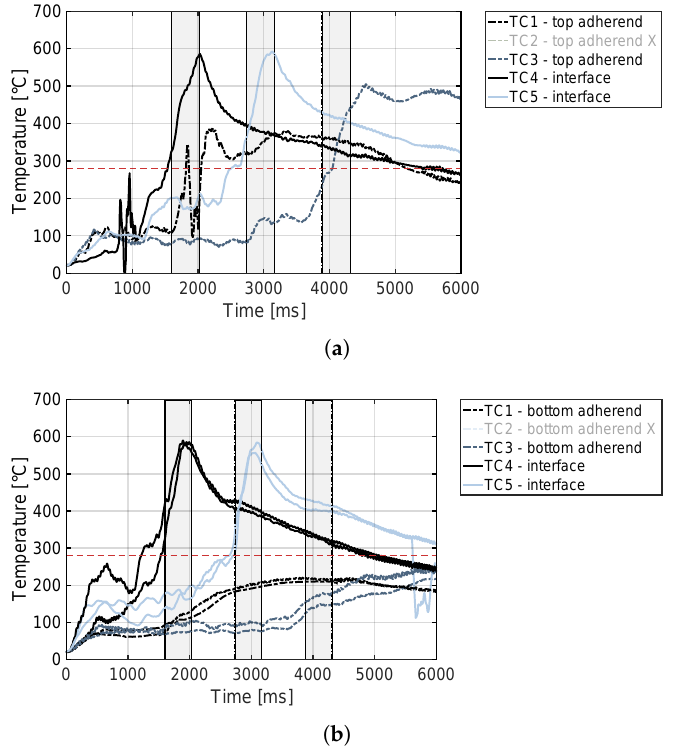
Figure 8. Temperature evolution for the continuous welding process at the weld interface and through the thickness for ( a ) the top adherend and ( b ) the bottom adherend. The grey areas indicate the time span during which a specific thermocouple was located under the sonotrode. The red dashed line indicates the melting temperature of PPS ( T m , 280 ◦ C) as experimentally determined by DSC